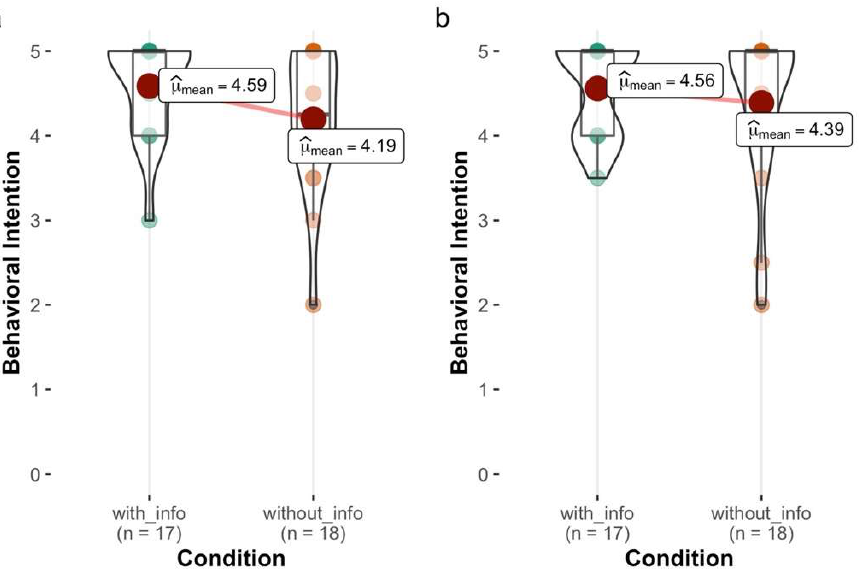
Figure 5. Differences in behavioral intention by condition. Violin plot illustrating descriptive differences in behavioral intention at T2 ( a ) and at T3 ( b ) according to condition.